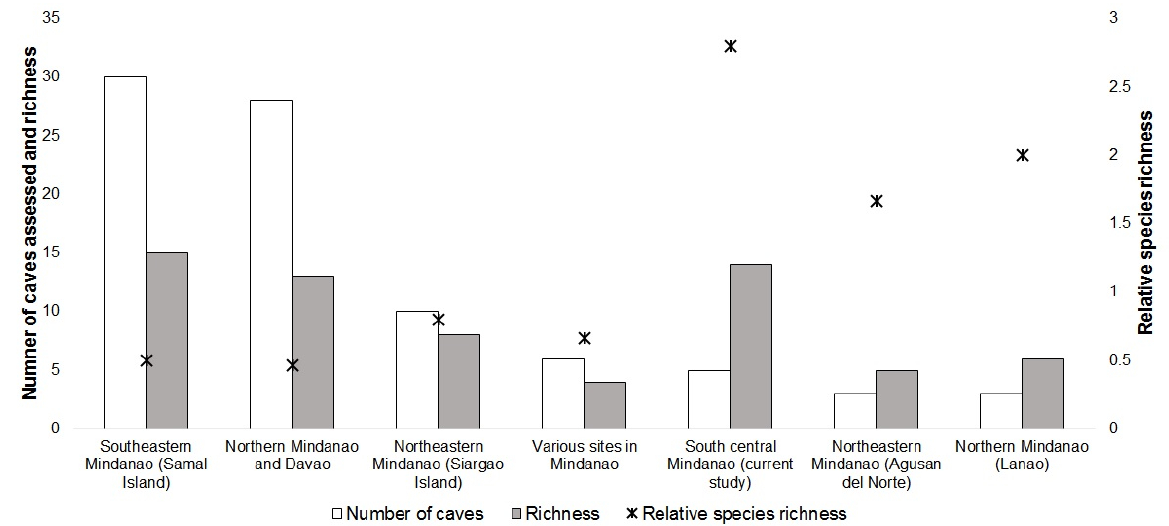
Figure 2. Relative species richness in selected cave sites on Mindanao Island, Philippines, calculated by dividing the total number of species recorded (r) by the total number of caves assessed (Nuňeza et al. 2010; Quibod et al. 2013; Requiroso et al. 2013; Warguez et al. 2013; Maca- alang et al. 2014; Nuňeza et al.